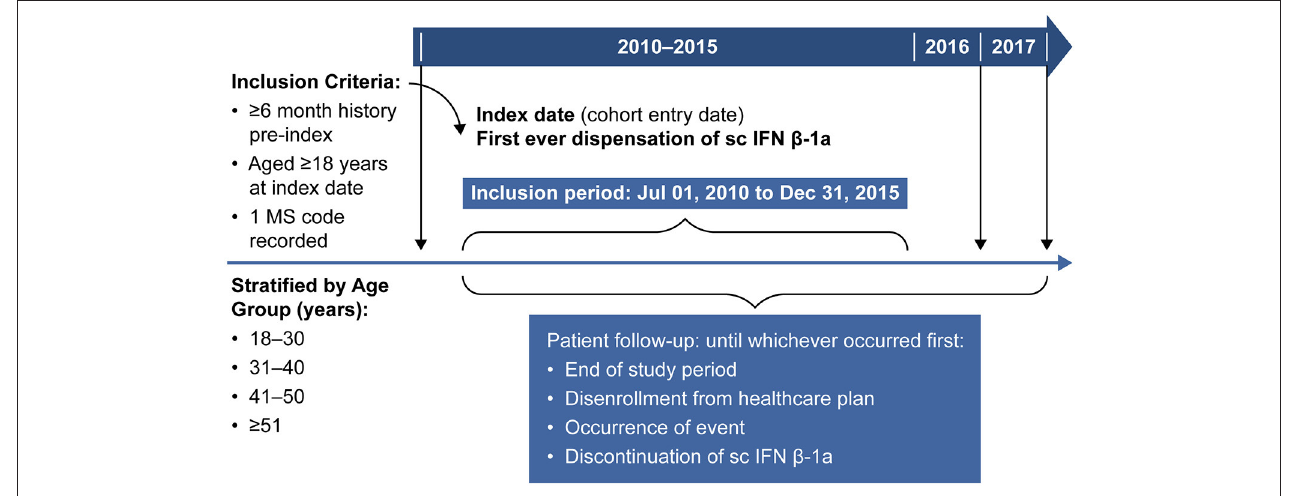
FIGURE 1 | Study design. MS, multiple sclerosis; sc IFN β -1a; subcutaneous interferon